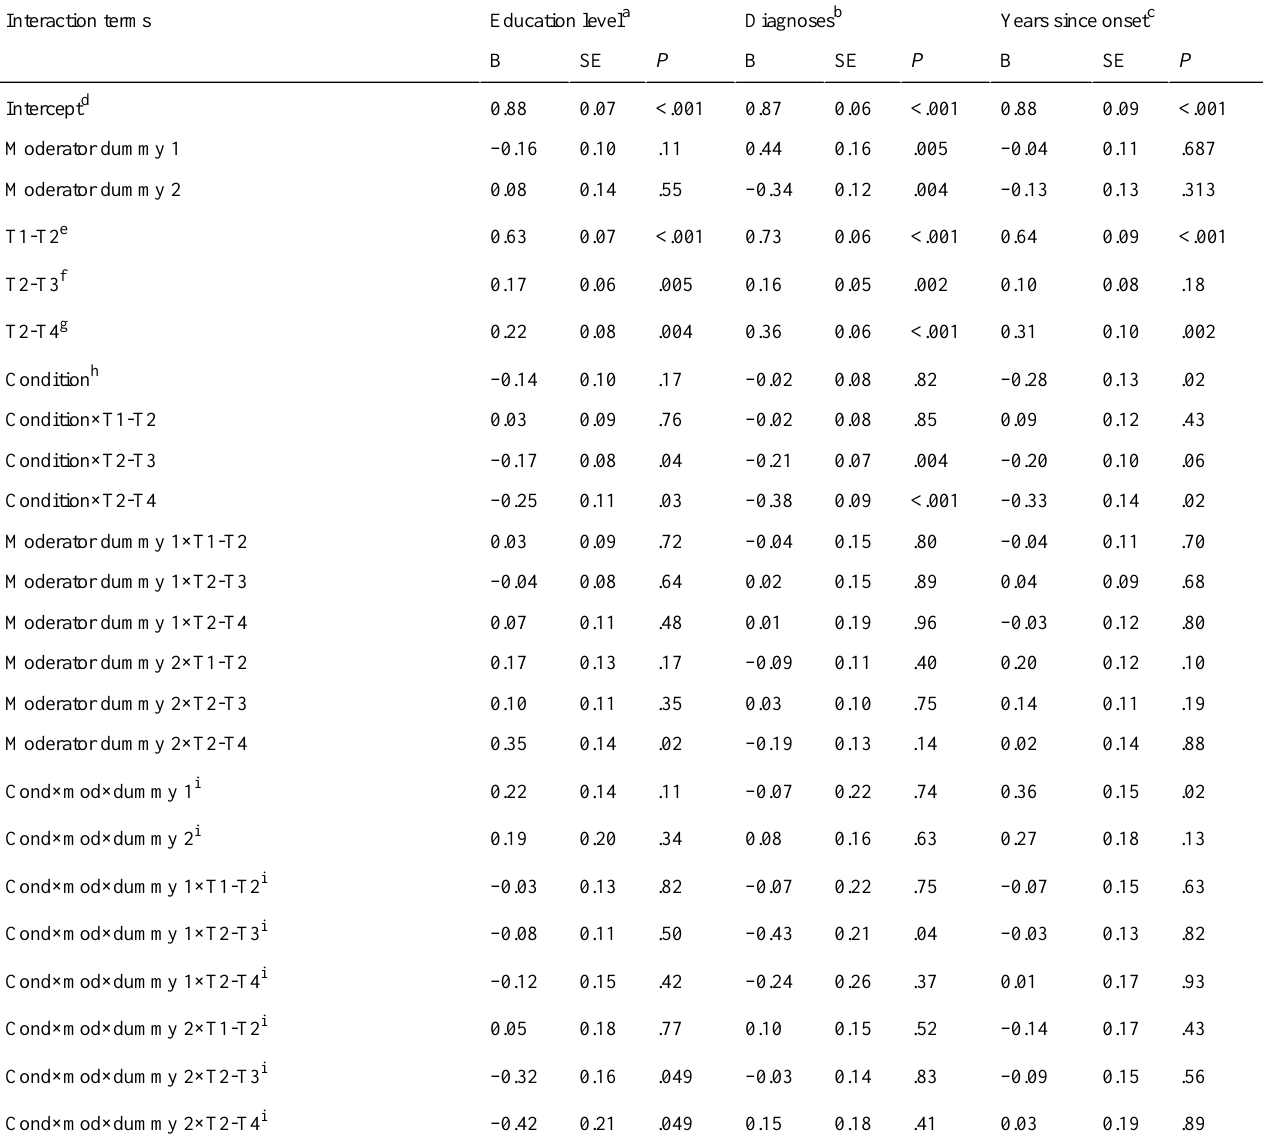
Table 4. Multilevel results for interactions between pretreatment participant characteristics (trichotomous moderator variables), intervention condition, and change in psychopathological symptom severity (dummy coded) for the intention-to-treat sample (N=400) using full maximum likelihood